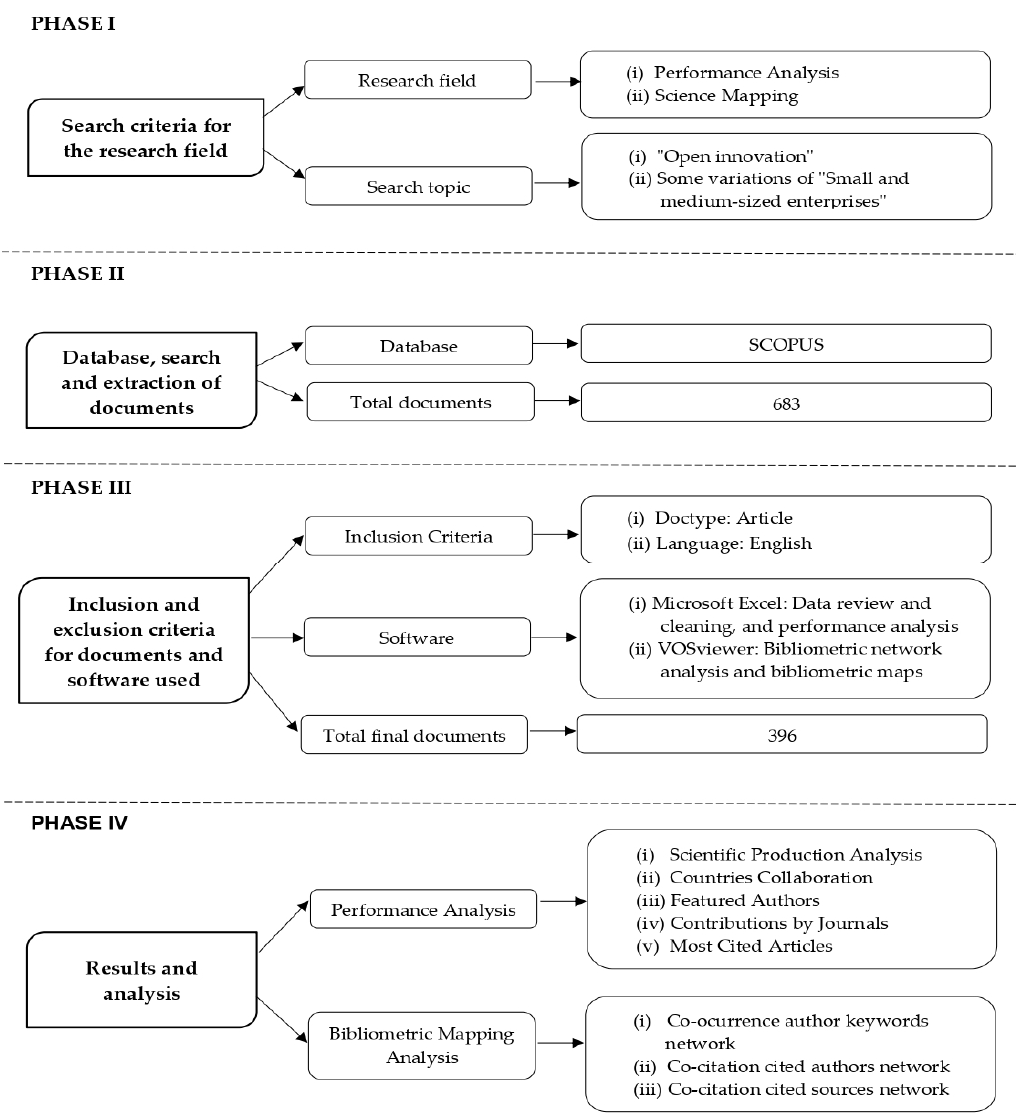
Figure 1. Bibliometric research methodology.